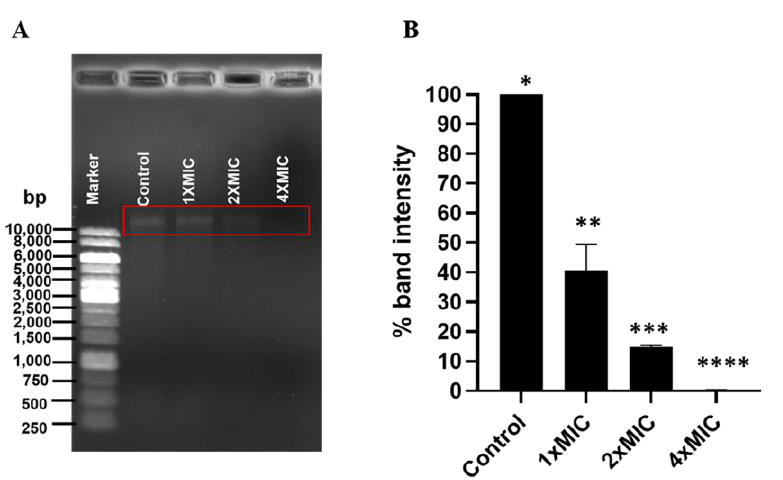
Figure 6. Agarose gel electrophoresis of genomic DNA of L. monocytogenes treated with COS-EGCG conjugate at different concentrations ( A ) and the band intensity (%) of DNA treated with COS- EGCG conjugate at various concentrations ( B ). The different asterisks on the bars denote significant differences ( p < 0.05) The results are presented as means ± SD ( n = 3).